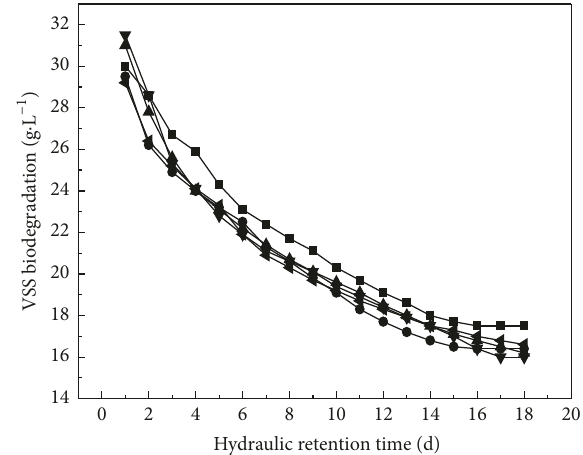
Figure 3: The influence of stirring rate on VSS removal. Stirring rate/r ⋅ min −1 : ◼ 125; e 145; 󳵳 165; 󳶃 185; 󳶣